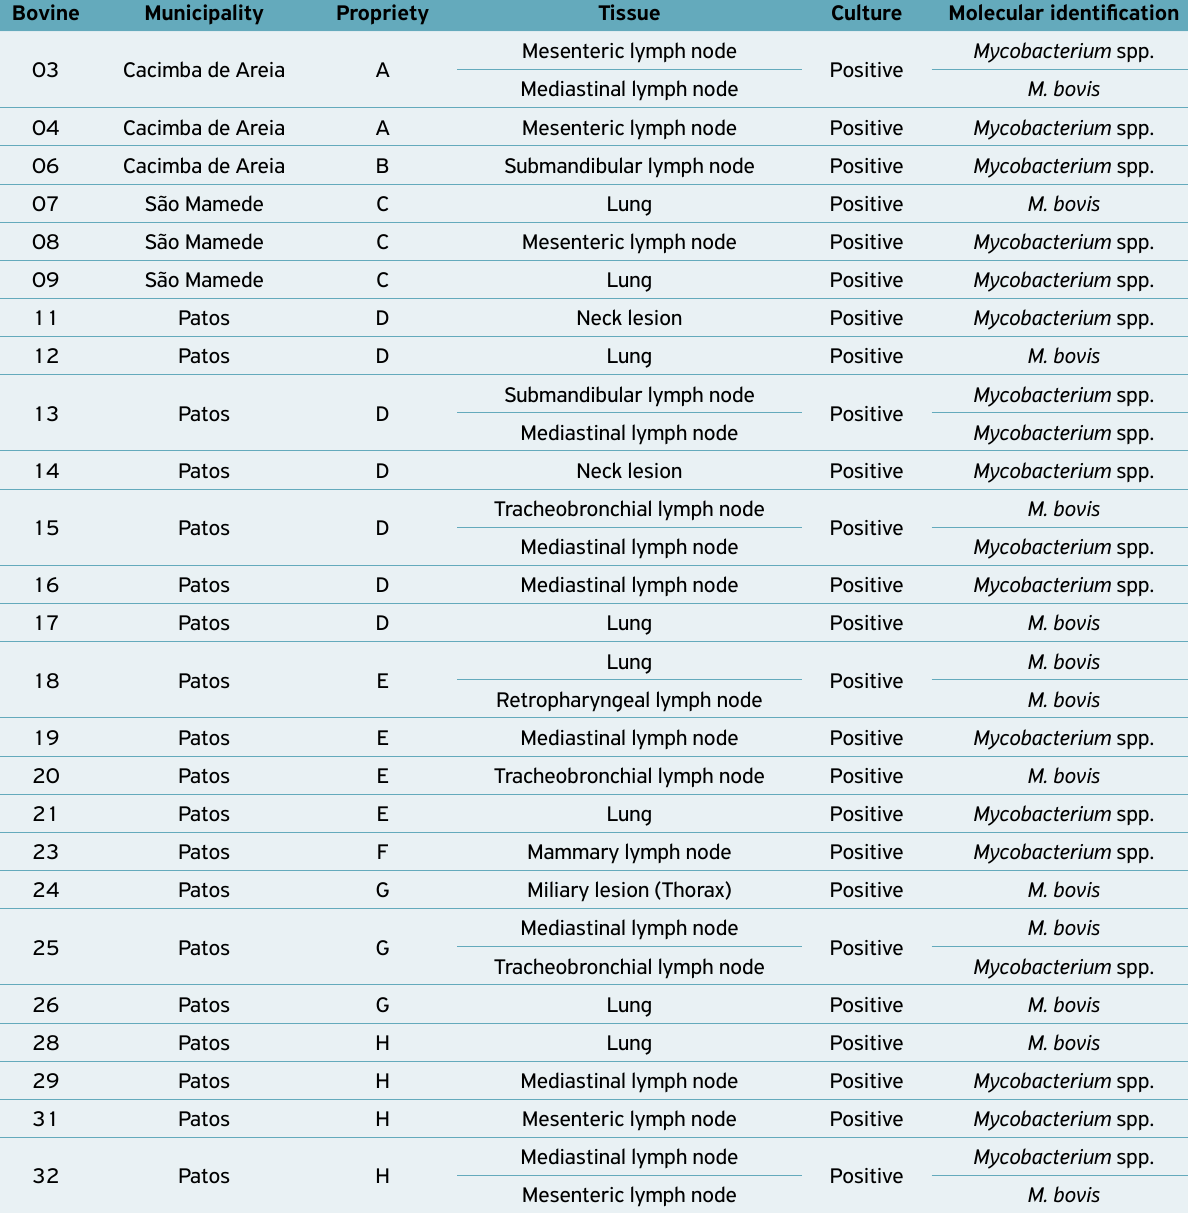
Table 1. Results of culture analysis and identification of samples using TB Multiplex‑PCR for amplification of M . tuberculosis complex and RD‑4 primers for identification of M . bovis in the state of Paraíba, from March to November 2014. Bovine Municipality Propriety Tissue Culture Molecular